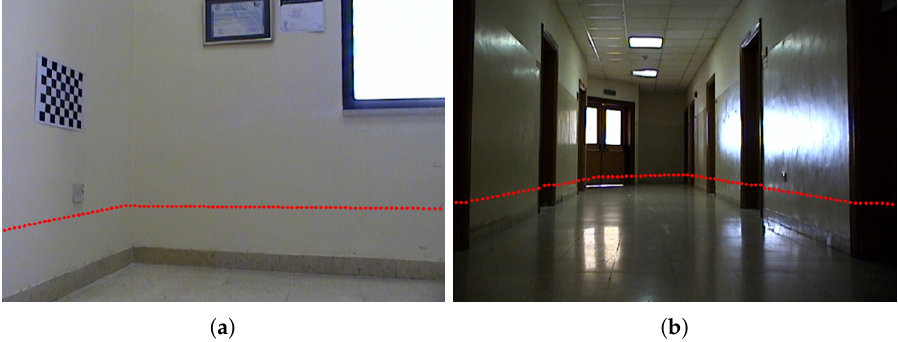
Figure 13. Configuration 2: The projection of the range data to two test images using the estimated Z matrix (points are shown in red color): ( a ) first test image; ( b ) second test